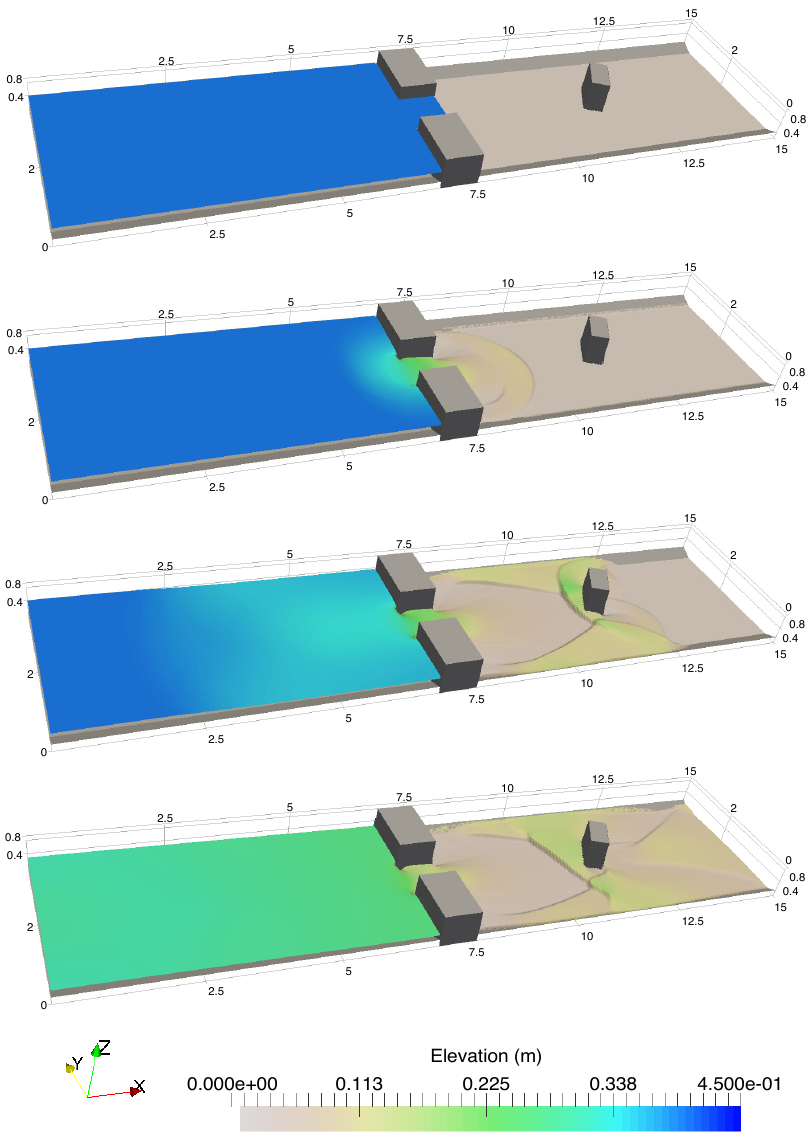
Figure 10. Case 2: visualization of the flood propagation at 0, 1, 3, and 10 s using the CU scheme. The domain was discretized into 200,704 rectangular cells (402,304 edges). The simulation time was set to 20 s with ∆ t = 0.002 s leading to 10,000 time steps. One can see in Figure 12, the incident solitary waves in front of the island, which generate a high run-up at about t = 9 s, create wet–dry mechanisms on the conical island. Within this period, the maximum magnitude was reached. After t = 9 s, the waves started to run down the inundated area on the conical island. Some waves were refracted and propagated toward the lee side of the island, where two waves were trapped at each side of the island at around t = 11 s. At t = 13 s, the second wave run-up was generated after these two waves collided. Afterwards, these waves continued to propagate around the